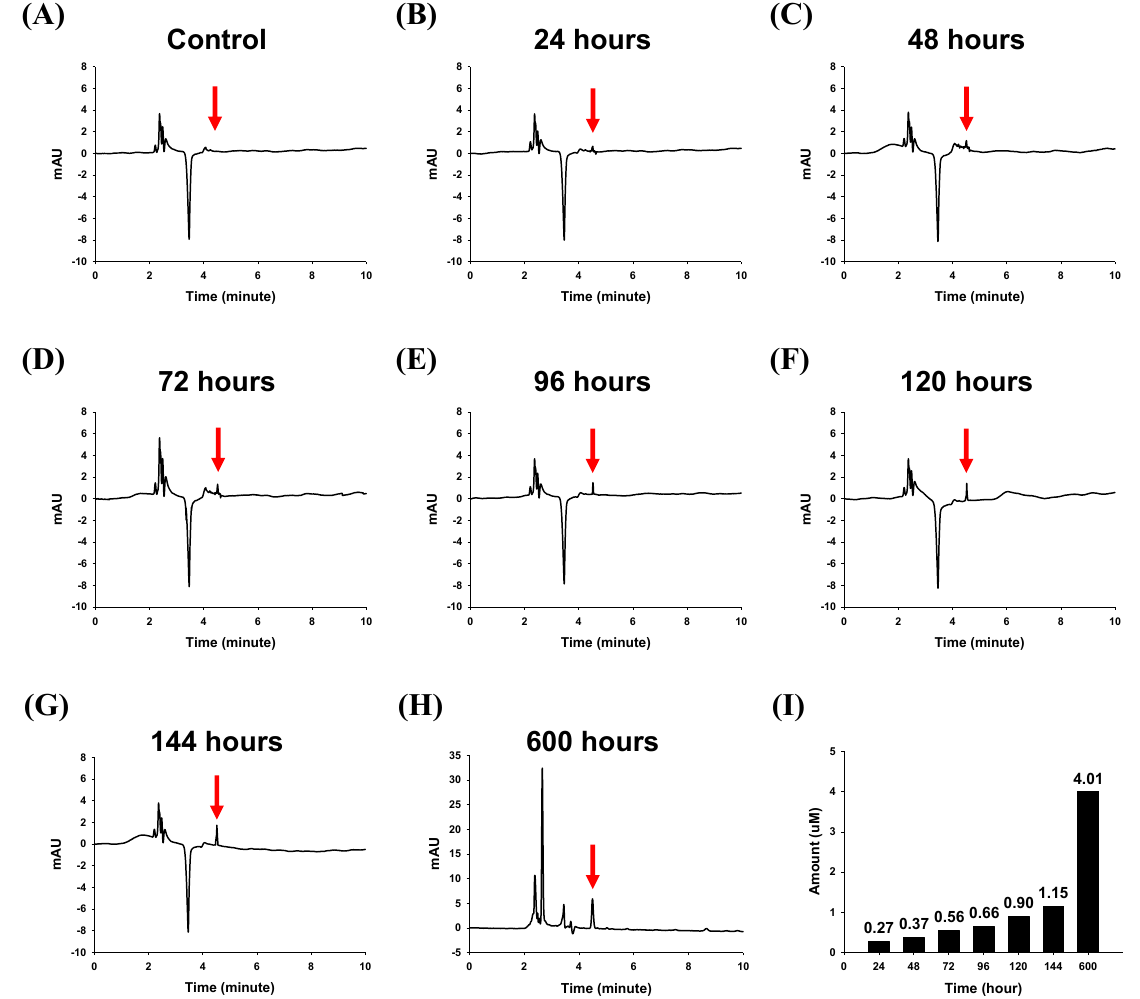
Figure 3. HPLC analysis results from one hundred of the 40-μm sizedmicrostructures in PBS solution. ( A ) Chromatogram of the microstructures without lapatinib powder; ( B) –( H ) Chromatograms of the lapatinib powder-entrapped microstructures after 24, 48, 72, 96, 120, 144, and 600 h; ( I ) Amounts of lapatinib released from one hundred of the 40-μm sized microstructures after 24, 48, 72, 96, 120, 144, and 600 h were 0.27, 0.37, 0.56, 0.66, 0.90, 1.15, and 4.01 μM,